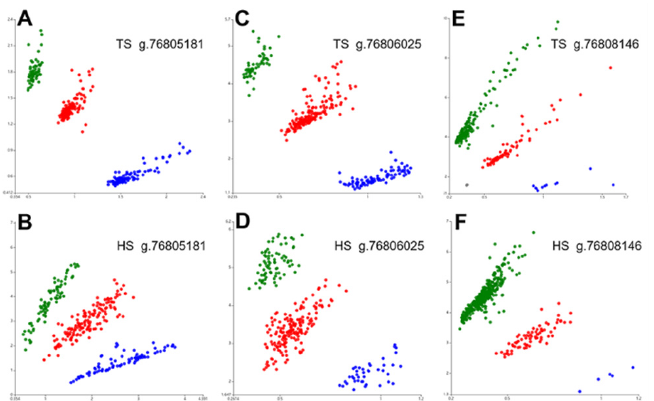
Figure 2. PCR amplification and sequencing results of Tibetan sheep HIF1 α -E9 ( A ), HIF1 α -E10 ( B ) and HIF1 α -E12 ( C ), the overlapping peak indicates the SNPs.